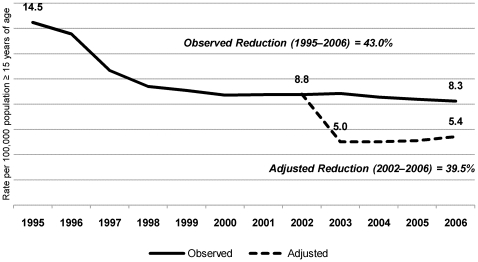
Evolution of AIDS mortality rates adjusted by excluding avoidable deaths.